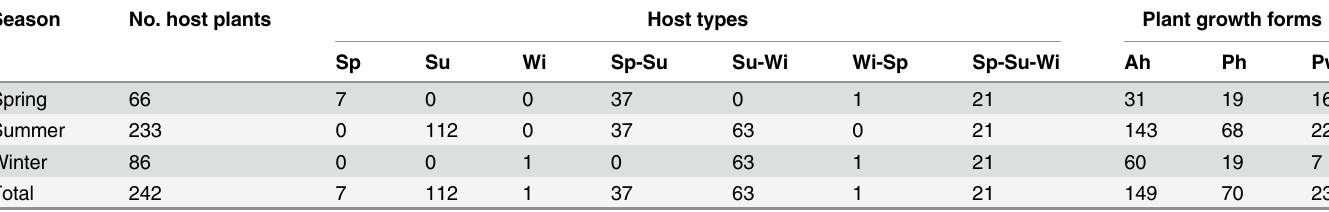
Table 2. A summary of host plant use of Apolygus lucorum in the summer and other two seasons at Langfang (Hebei Province, Northern China). Season No. host plants Host types Plant growth